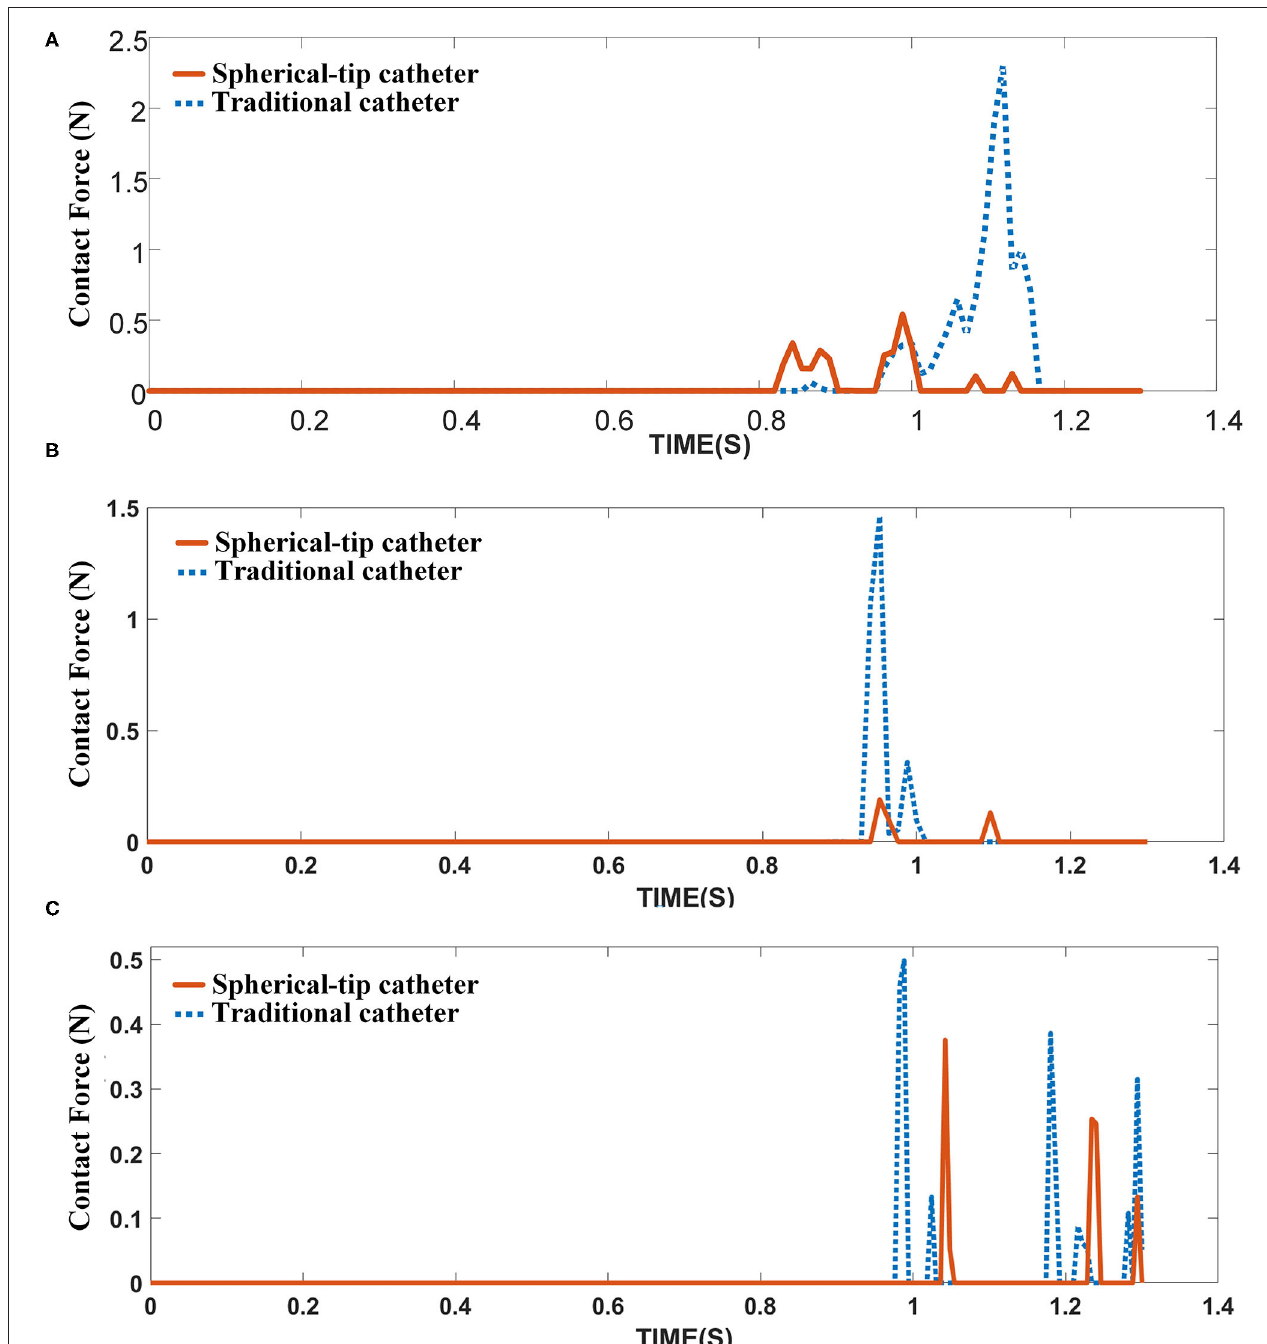
FIGURE 12 | Contact force between catheter tips and the inner surface of the stent under different curved vessels with (A) curvature radius of 10 mm, (B) curvature radius of 20 mm, and (C) curvature radius of 30mm.